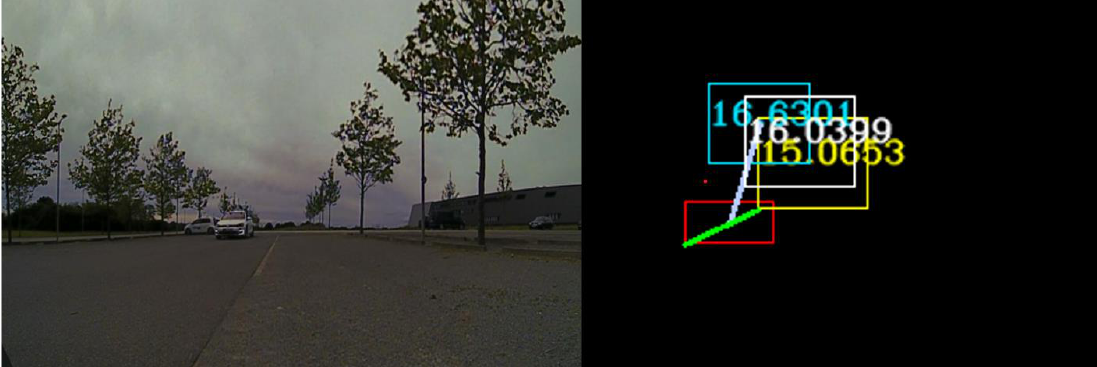
Figure 14. Associations between measurements coming from different sensors and their fusion. On the left-hand side, we observe the RGB image. On the right-hand side, we observe the data associations among sensors as well as the super-sensor object depicted in white.